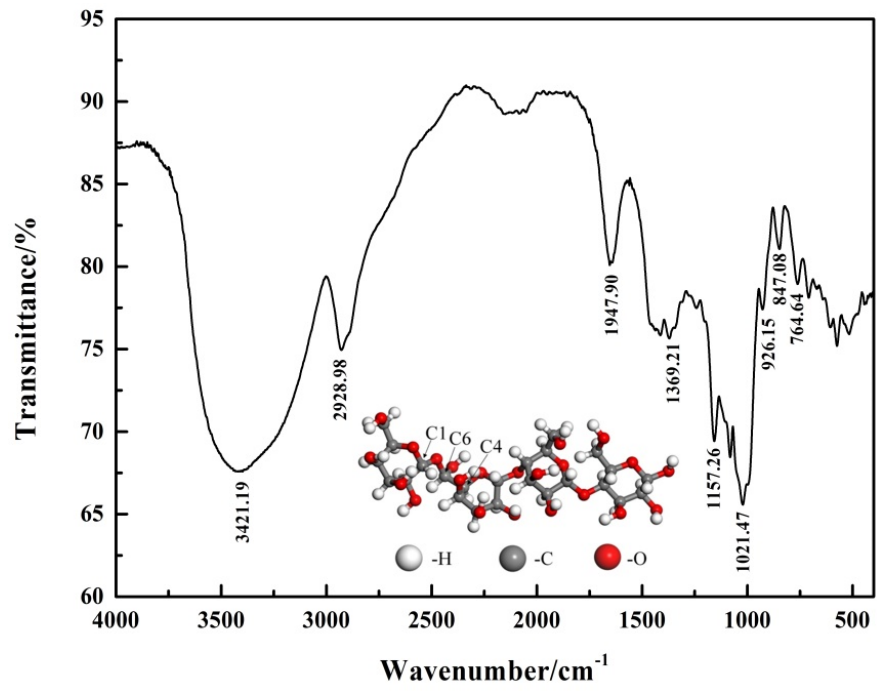
Figure 2. FT − IR spectrum of